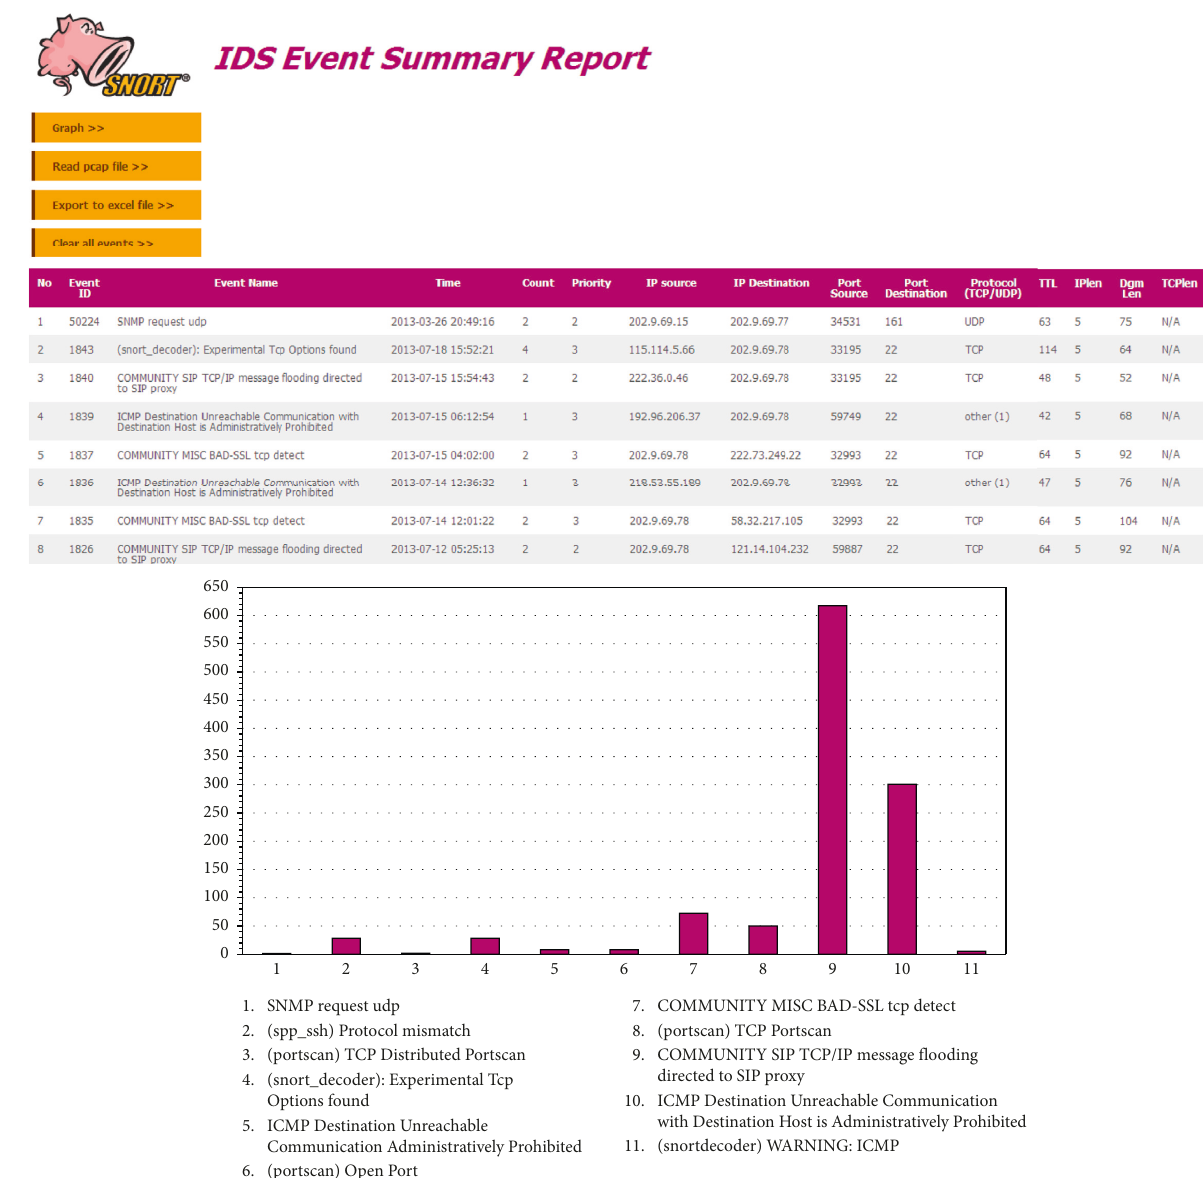
Figure 9: Snort alert